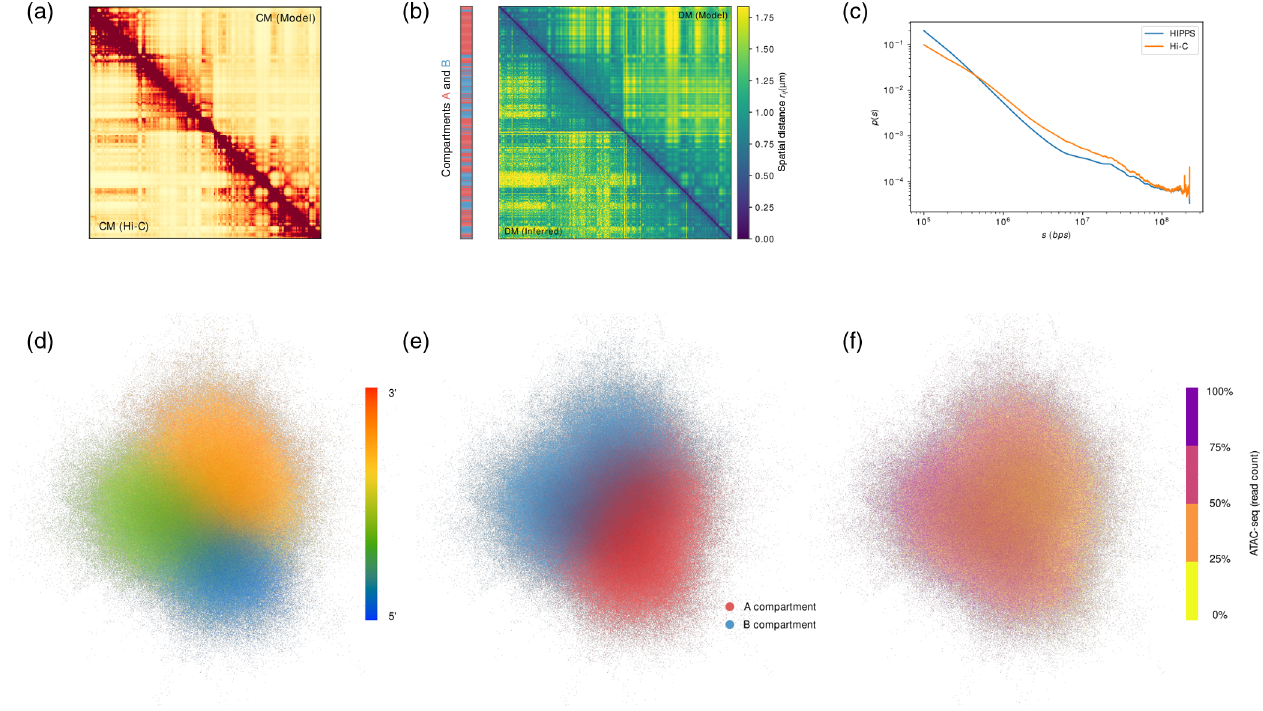
FIG. 5. (a) Comparison between the Hi-C (lower triangle) and the contact maps calculated from an ensemble of 3D structures for ¯ R chromosome 1 using the HIPPS method ( h P i → h i → 3D structures → contact map). (b) Comparison between the distance matrix inferred from the Hi-C data (lower triangle) and the distance matrix calculated from an ensemble of 3D structures for chromosome 1 ¯ R using the HIPPS method ( h P i → h i → 3D structures → mean distance map). A and B compartments, determined using spectral biclustering [29], are also shown. (c) Comparison between the contact probability profile P ð s Þ inferred from experiment and the calculated curve using the HIPPS method. (d) Superposition of 1000 3D structures for chromosome 1. Each point represents one locus from one conformation. The cloud representation demonstrates the probabilistic nature of chromosome conformation, with color representing the genomic location of the loci along the genome. The resolution of the locus is 100 kbps. (e) Same cloud point representations as (d) with colors indicating the A and B compartments. Phase separation between A and B compartments is vividly illustrated. (f) Same as (d) and (e) but with ATAC-seq read counts coded in